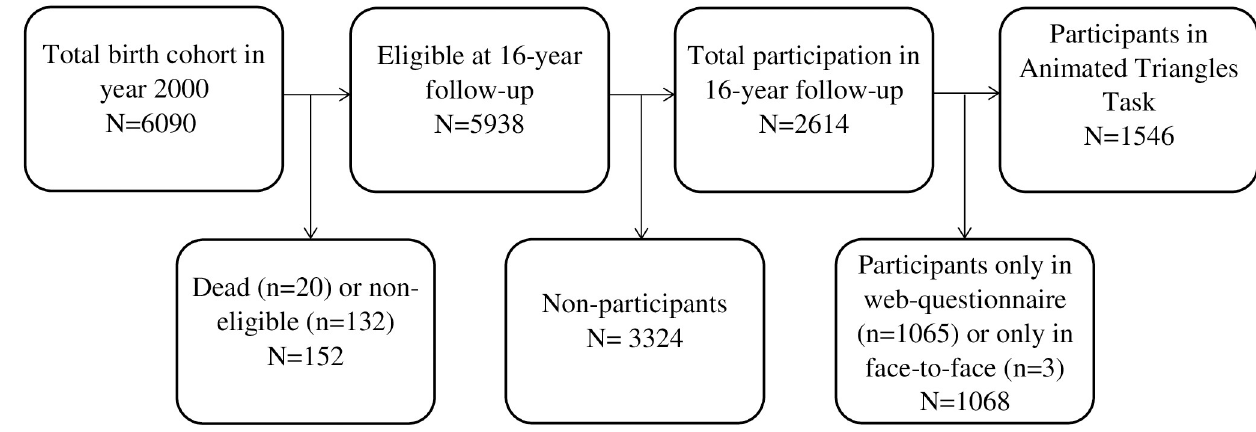
Fig 1. Flowchart of participation in the Animated Triangles Task.